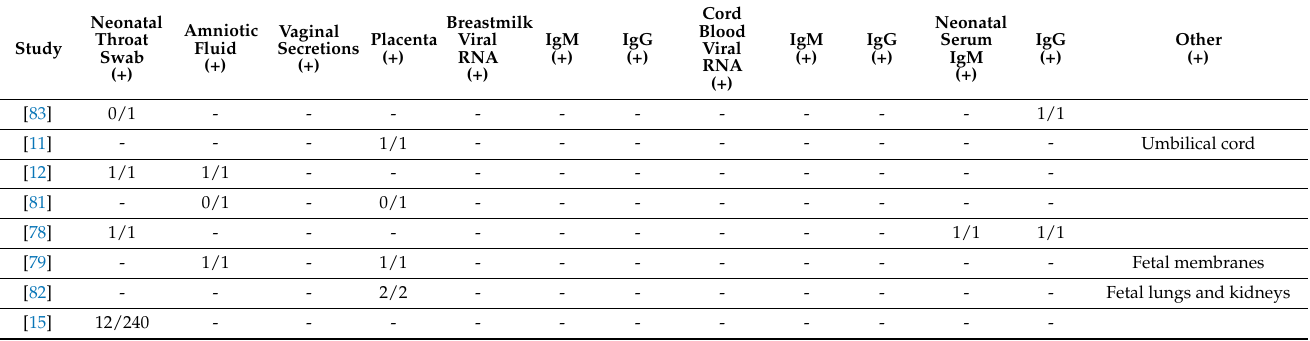
Table 3. An overview of the reported evidence on vertical transmission in pregnant patients diagnosed with COVID-19 as described in the included